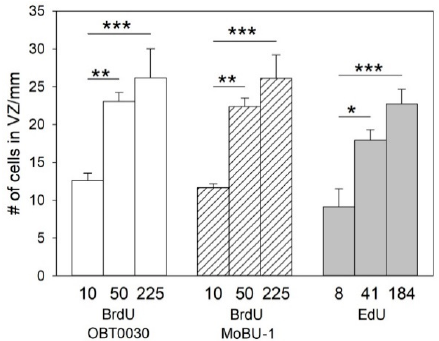
Figure 2. The mean number of BrdU + or EdU + cells in the VZ. BrdU was detected by OBT0030 and MoBU-1 antibodies. The x-axis shows doses of BrdU and EdU (equimolar to the doses of BrdU). Each bar represents a mean and SEM. The dose 50 mg/kg of BrdU resulted in more labeled cells than the dose 10 mg/kg but did not differ from the dose 225 mg/kg. The same applies for equimolar doses of EdU. * is p < 0.05, ** is p < 0.01, *** is p < 0.001. ANOVA and Fisher’s LSD test.